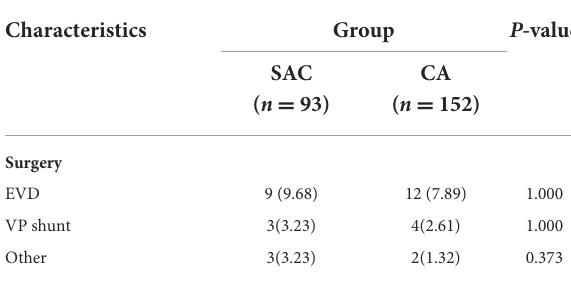
TABLE 1 Characteristics of patients at baseline.